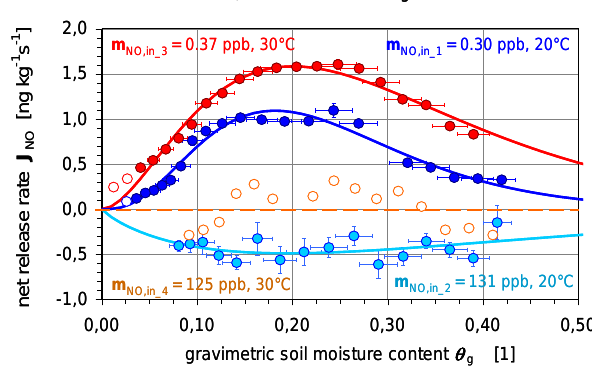
Figure 12. As Fig. 10, but for a sample taken from a grassland soil Fig. 12: as Fig. 10, but for a sample taken from a grassland soil (Finthen, W-Germany). (Finthen, W Germany). Data points marked by empty circles fall Data points marked by empty circles fall within the “deadband” of non- within the “deadband” of non-detectable J NO values (defined by detectable J NO -values (defined by ± minimum detectable net NO release rate; s. ± minimum detectable net NO release rate; see Sect. 4.2). Sect. 4.2). NO compensation point mixing ratio m NO , comp , which has been determined to be 150 ± 43 . 3